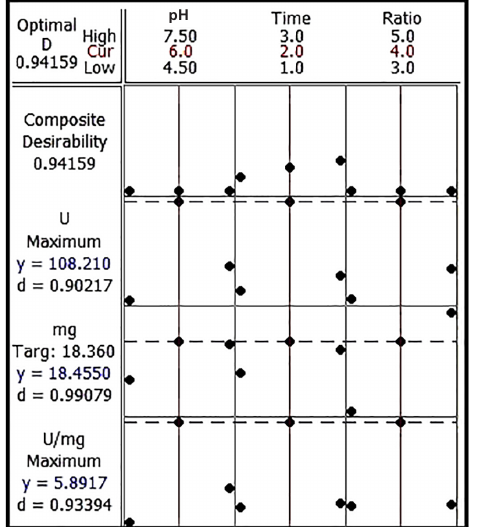
Figure 4 Response optimizer plots for interaction effects of extraction variables on total protein, total activity, and specific activity of